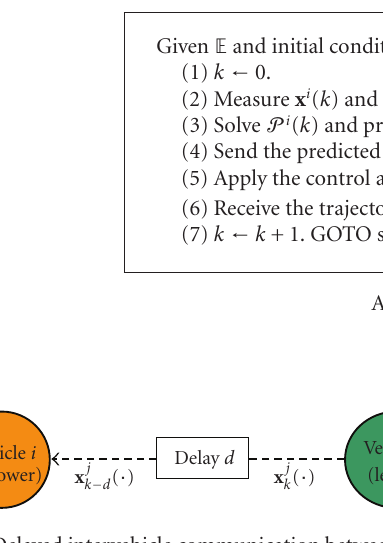
Figure 2: Delayed intervehicle communication between two neigh- boring vehicles.